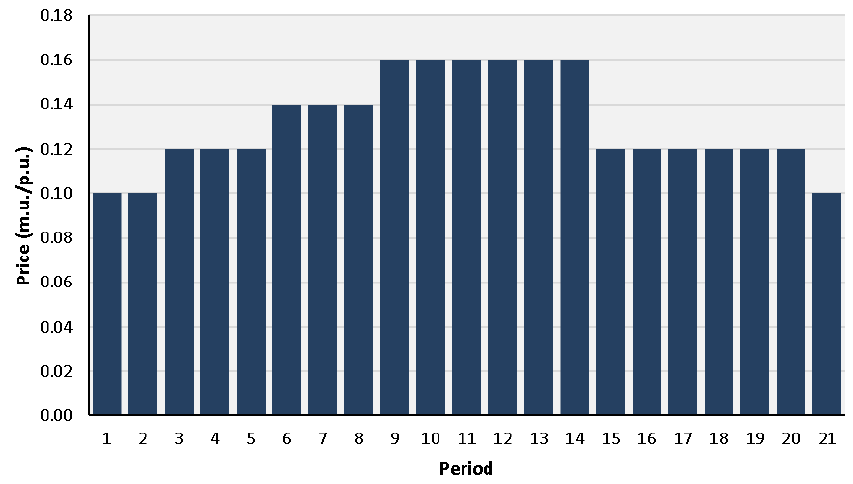
Figure 3. Dynamic tariff considered for the external supplier.